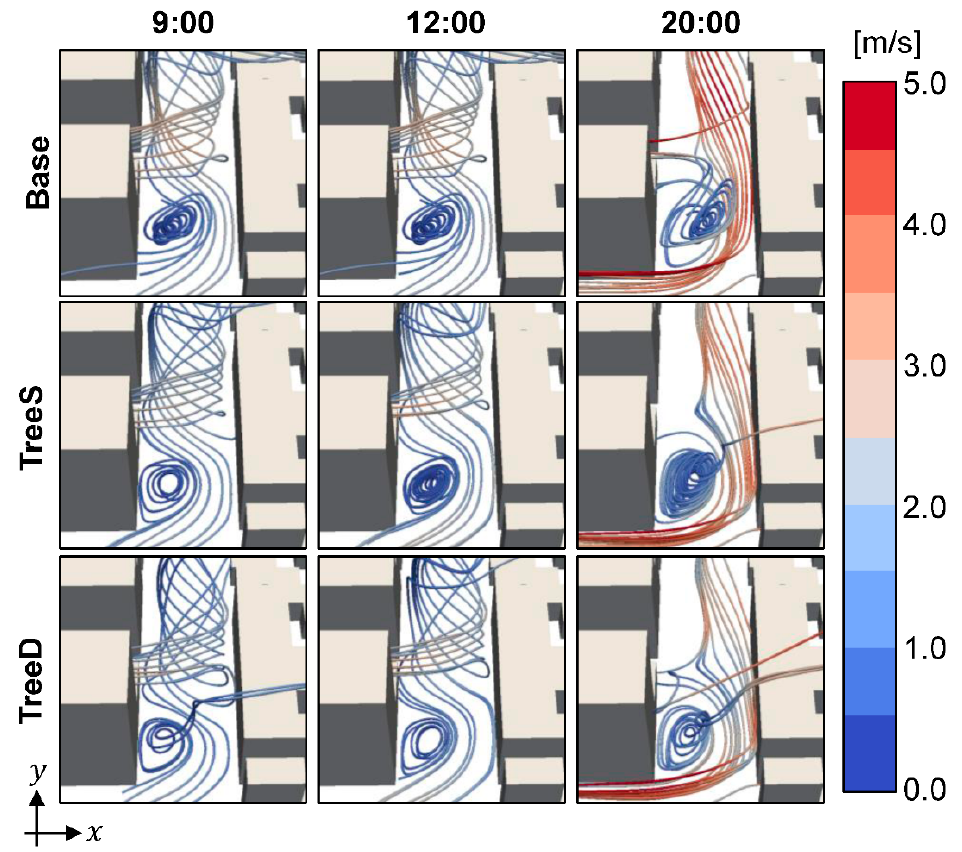
Figure 5. Stream tracers around the analysis domain at 9:00, 12:00 and 20:00 for each case (flow fields at 15:00 was omitted because these were similar to that at 20:00, respectively.).